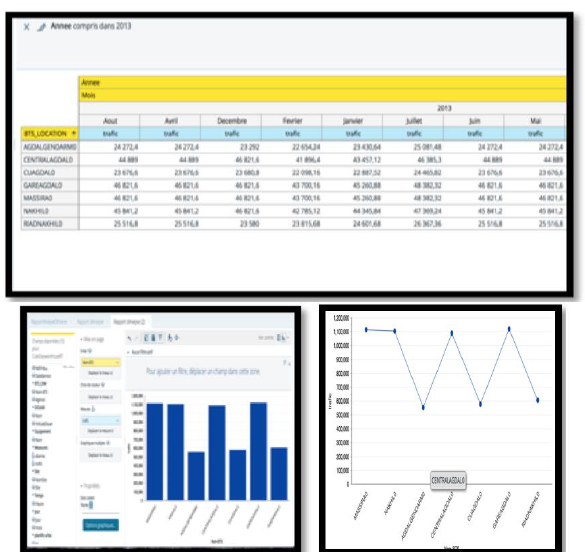
Figure 5.6.7. Data display in graphs and cross-table format The main interest of SOLAP is to represent data on a geographical background in order to offer a synthetic regional vision. (Figure 8) shows a recent satellite image of Rabat region, the dots in red represent each BTS is proportional to the annual traffic intensity recorded.